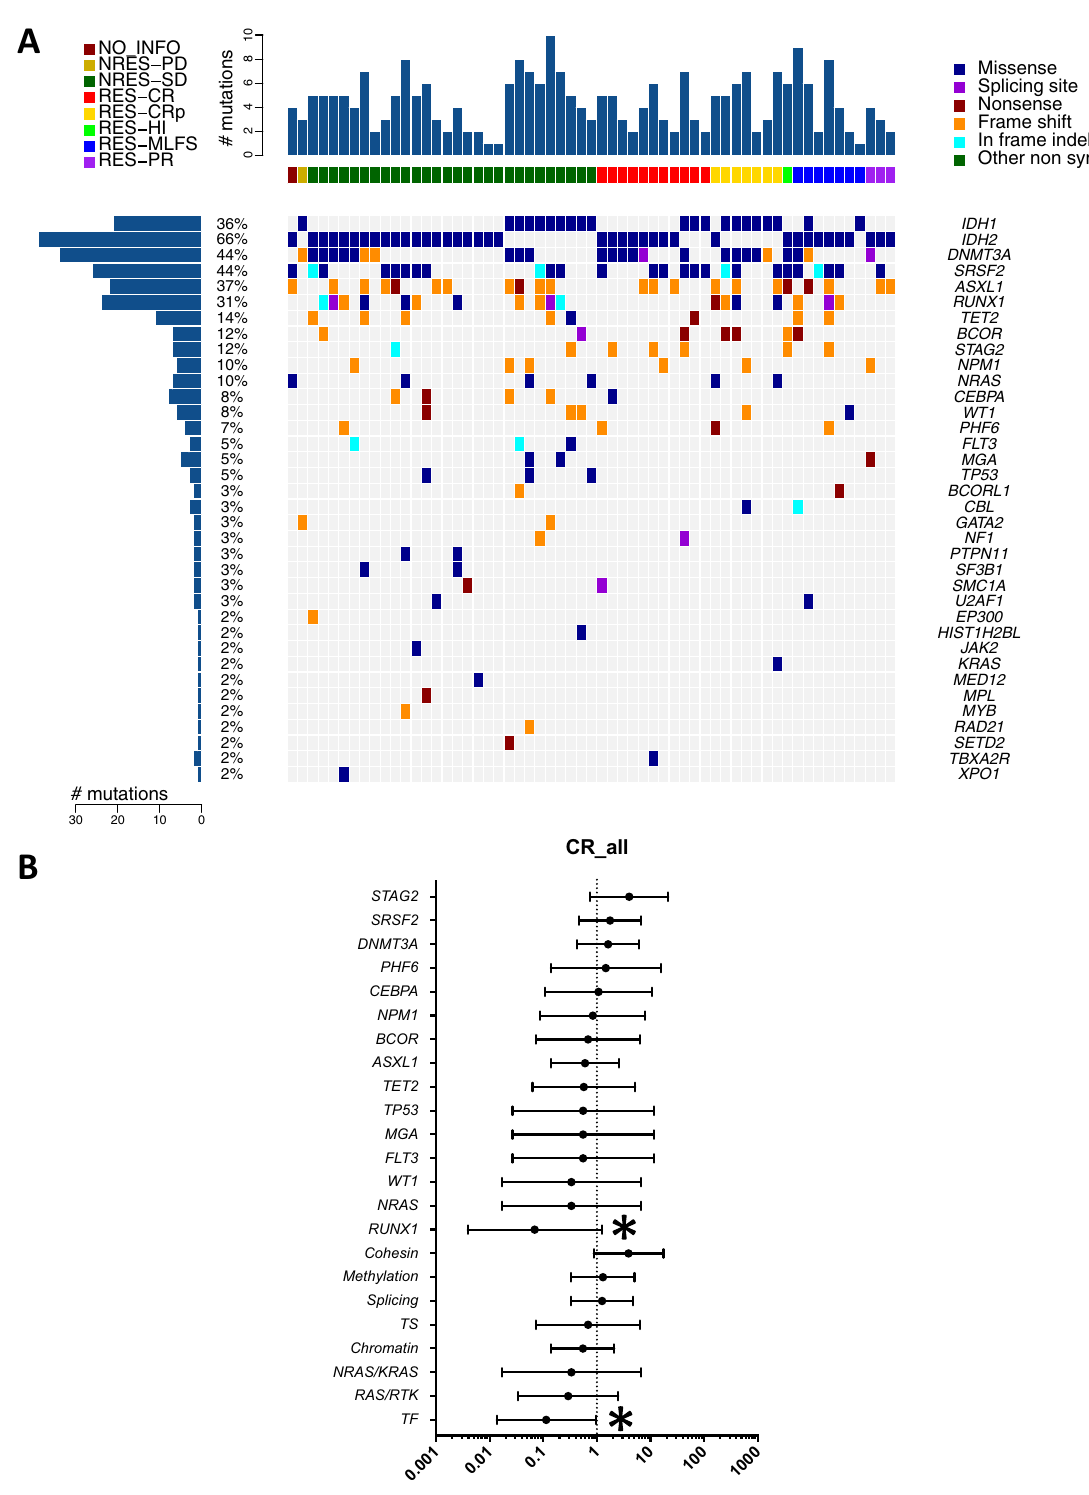
Fig. 1 Mutational landscape of IDHi-treated AML patients and their association with clinical response. A Landscape of high-con fi dence somatic mutations detected in baseline samples by sequencing with a 295-gene panel. Legend for the best response is located at the top left, while legend for the mutation classi fi cation is located at the top right. Baseline mutation data are available for 59 patients. B Forrest plot showing enrichment of the mutations at baseline against complete remission (CR) by logarithmic odds ratio. Two-sided Fisher ’ s exact test was performed. * P < 0.05 ( P = 0.012 for RUNX1 ; P = 0.037 for TF). Circles (center of the error bars) represent odds ratios. The error bars represent 95% con fi dence interval of odds ratio. Baseline mutation data are available for 59 patients, out of which 11 achieved CR. Genes mutated in three or more patients are plotted. TS tumor suppressor, TF transcription factors. Source data are provided as Source data fi